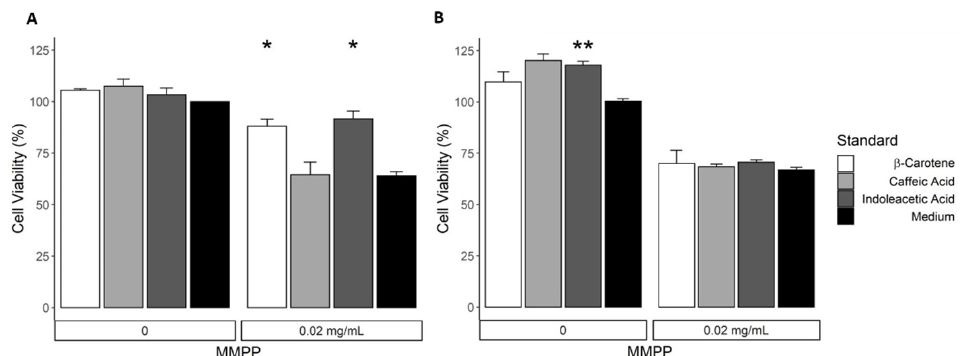
Figure 5. Effect of indoleacetic acid, β -carotene and caffeic acid on the cell viability of HEK-293 ( A ) and MDCK ( B ) in the absence or presence of MMPP after 24 ( B ) or 72 ( A ) hours incubation. Reported values correspond to mean of cell viability with standard error over three biological replicates. The percentage of cell viability was calculated using the ratio Abs TEST /Abs CTRL . * p < 0.05; ** p < 0.01.